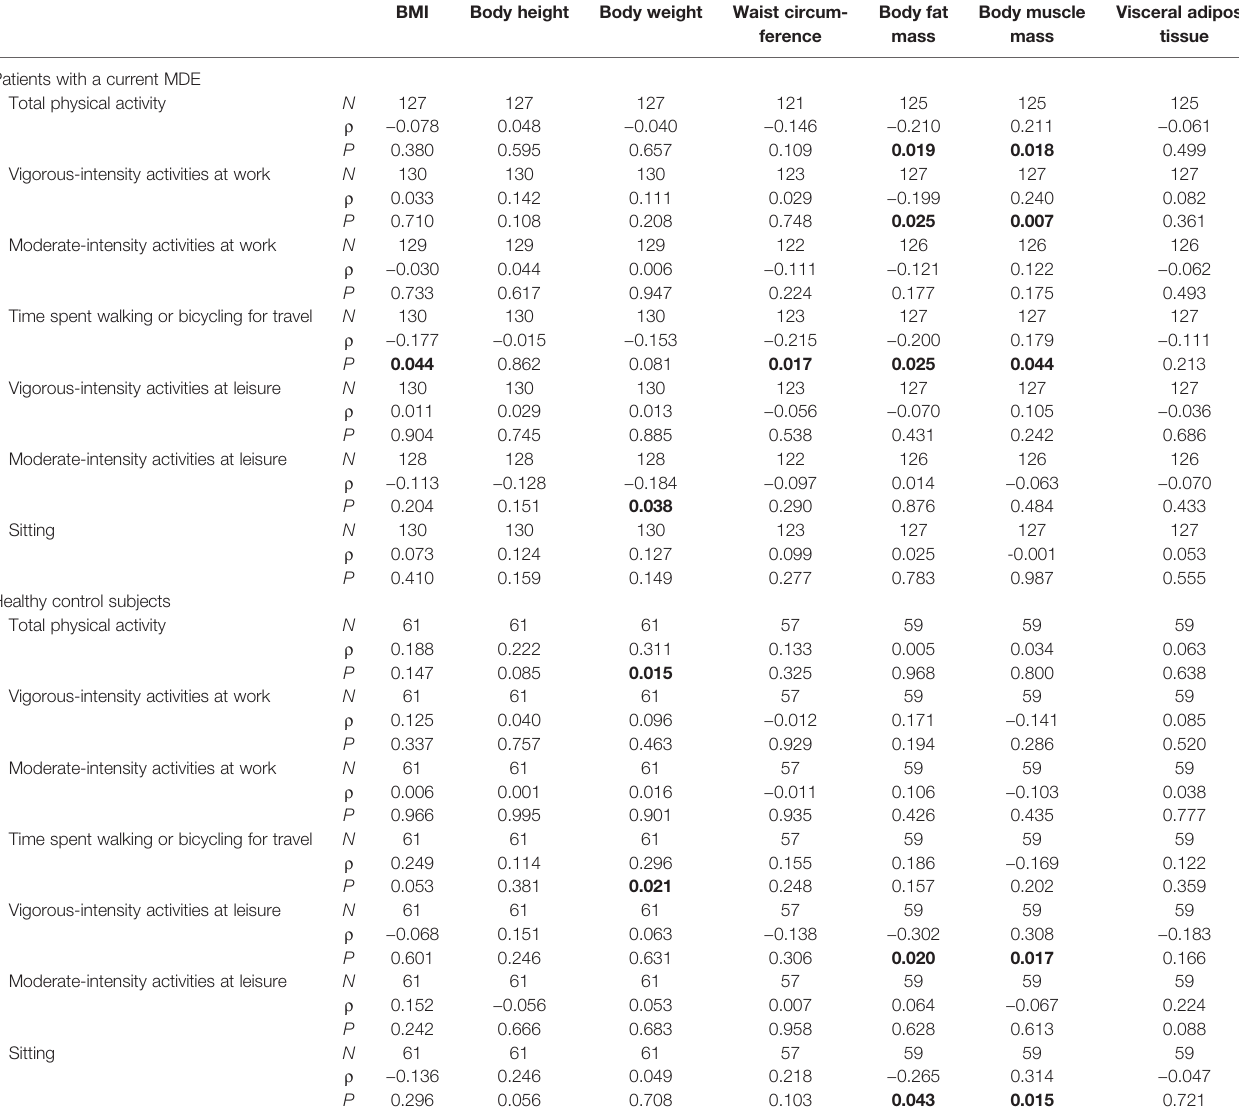
TABLE 4 | Spearman correlations between physical activity and body measures.